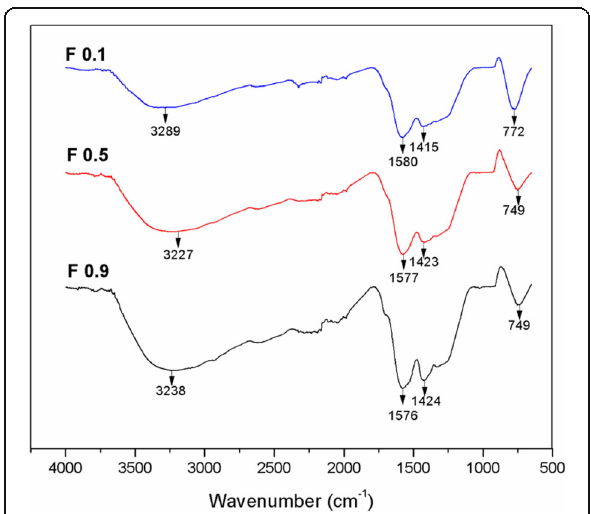
Fig. 3 X-ray diffraction patterns of a individual TiO 2 -CNF sample and b different flow rate